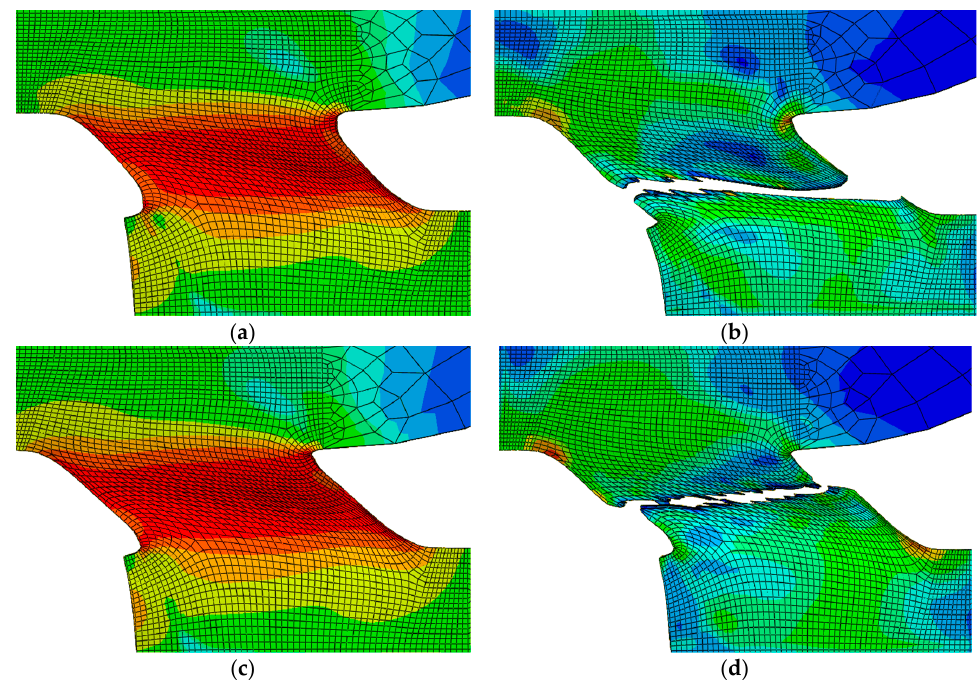
Figure 18. Results of the SYM-Shear − 30° specimen obtained using the modified N-VG model: ( a ) Stress contour and deformation of the hotspot region (u f eq = 0); ( b ) fracture path (u f eq = 0); ( c ) stress contour and deformation of the hotspot region (u f eq = 0.2); ( d ) fracture path (u f eq =